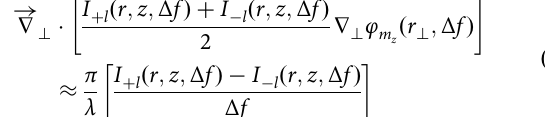
seen in Fig. 3a, b compared with that seen in The larger φ m z Fig. 1 results from using a narrow beam waist. The phase shift was determined for an EVB with a beam waist of 0.5 nm, which has been experimentally realized 53 . The phase shift and simulated images were created from sums of 100 different images with distance from the beam waist to the sample plane ranging from 10 nm to 100 μ m. When implementing Eq. (12) the objective lens defocus was 50 nm, and when implementing the alternative phase reconstruction algorithm in Eq. (13) the objective lens defocus was 0.1 μ m due to the weaker restriction of Δ f . Images used in the reconstruction were simulated with all three ; φ ; φ Þ , but assuming ideality, components of phase shift ð φ m z m xy E . the OAM-TIE approach will enable us to reconstruct φ m z for an EVB with OAM = 20, Figure 3c.i shows the simulated φ m z imparted by a nanoparticle with magnetization directed along the ) (indicated by superscript ↓ ) in gray- negative z -direction ( ν ¼ 5 π 6 . Figure 3c.ii-iii shows the scale, this is the ground truth φ m z reconstructed phase shift, indicated as φ R , obtained using Eqs. (12) and (13), respectively. Images obtained using EVBs with OAM = + 20 and − 20 were used to implement the phase reconstruction, Eq. (12), the implementation of the phase reconstruction is discussed in the Methods Section. Figure 3d.i – iii show the simulated φ and reconstructed phase shifts, respectively, for a nanoparticle m z ) with magnetization directed along the positive z -direction ( ν ¼ π 6 (indicated by superscript ↑ ) imaged with an EVB of OAM of ±